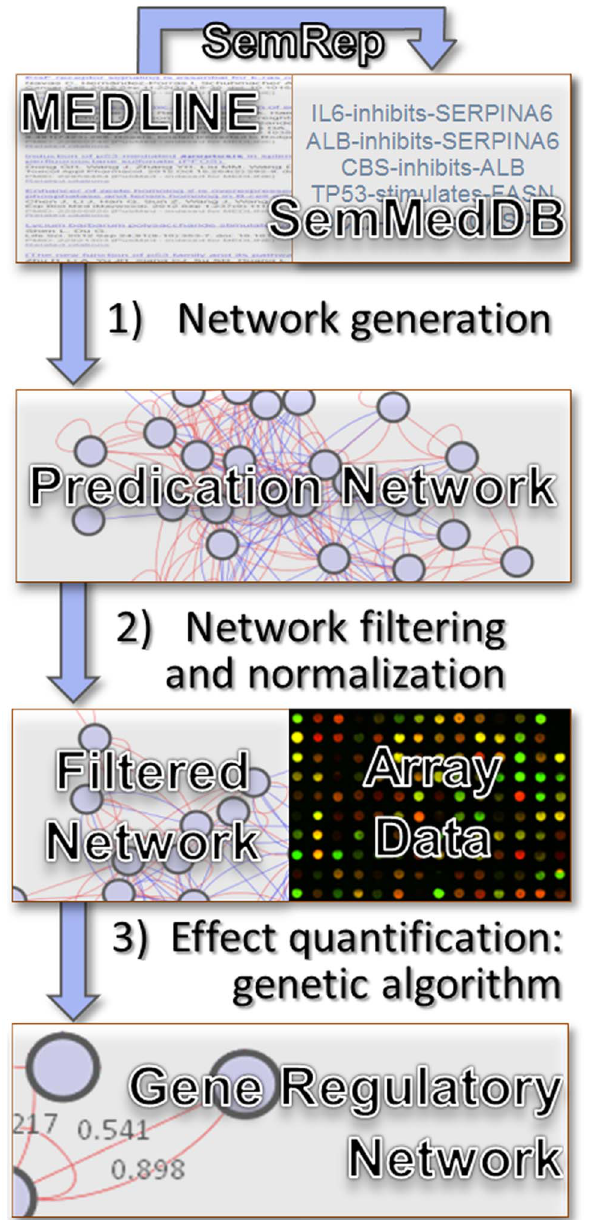
Figure 1. Literature-based gene regulatory network discovery schema. Step 1) a network is formed from semantic predications extracted from MEDLINE by SemRep for each set of citations related to a given pathway; Step 2) each network is filtered by predication argument distance and frequency; Step 3) a genetic algorithm uses gene expression data to quantify the weight of the interactions of the gene regulatory network.